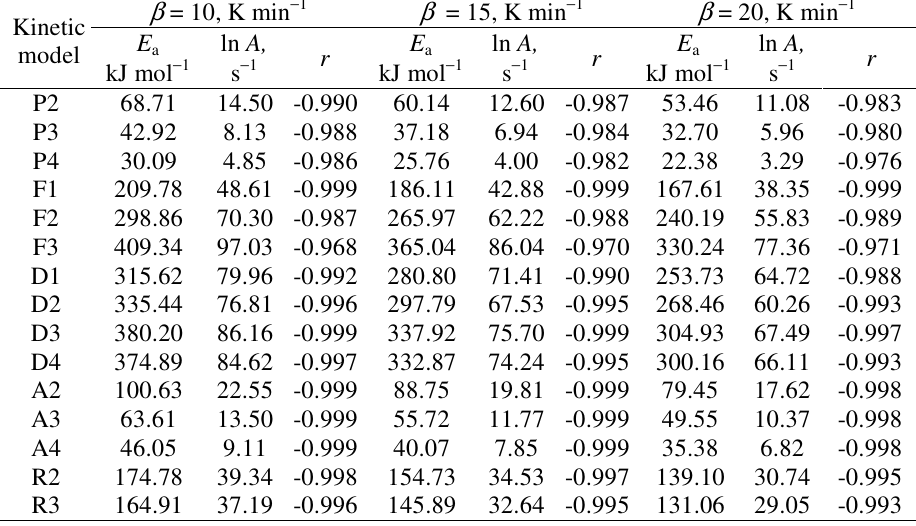
Table 2. Kinetic parameters for the first stage decomposition of HBAPPA